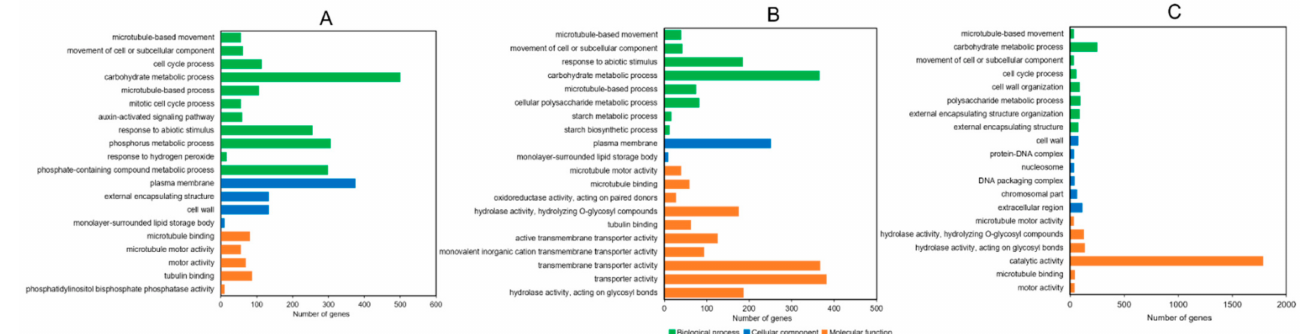
Figure 6. Gene ontology (GO) enrichment analysis of DEGs among CK, HYD and HEHP. ( A ) Top 20 enriched GO terms of the DEGs identified in CK vs. HEHP; ( B ) Top 20 enriched GO terms of the DEGs identified in CK vs. HYD; ( C ) Top 20 enriched GO terms of the DEGs identified in HYD vs. HEHP.